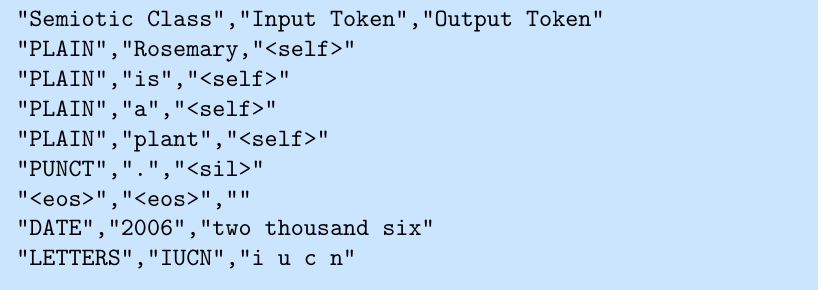
Figure 2. Sample text from the original dataset